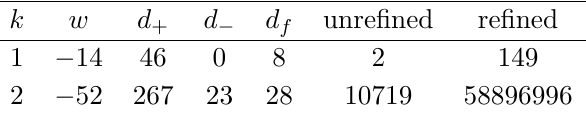
Table 14 . Numbers of possible terms in the numerator of the k -string for g = d invariant Jacobi